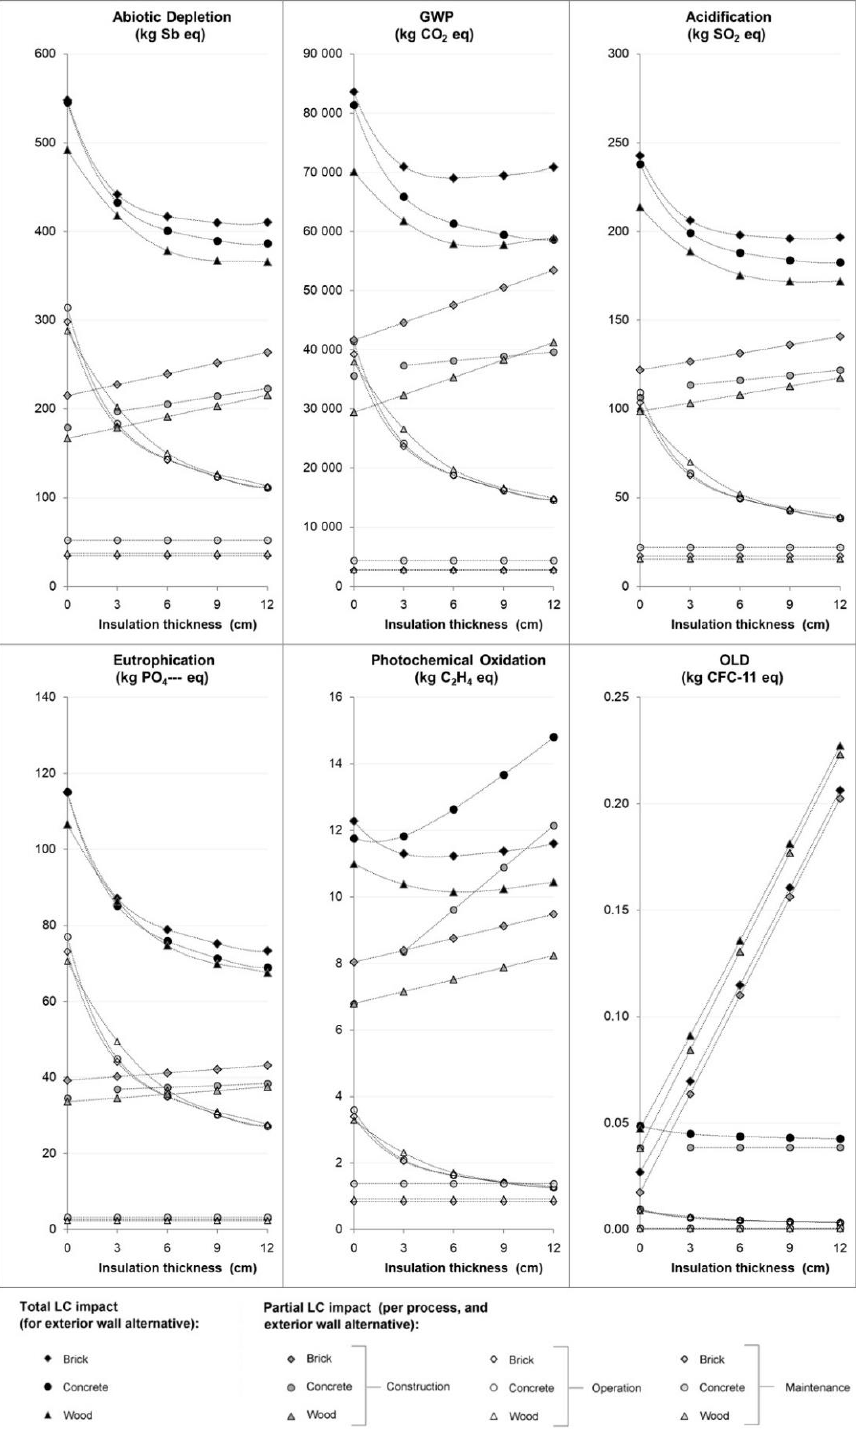
Figure 6. LCIA house results for OP50: exterior wall construction alternatives vs. insulation level.